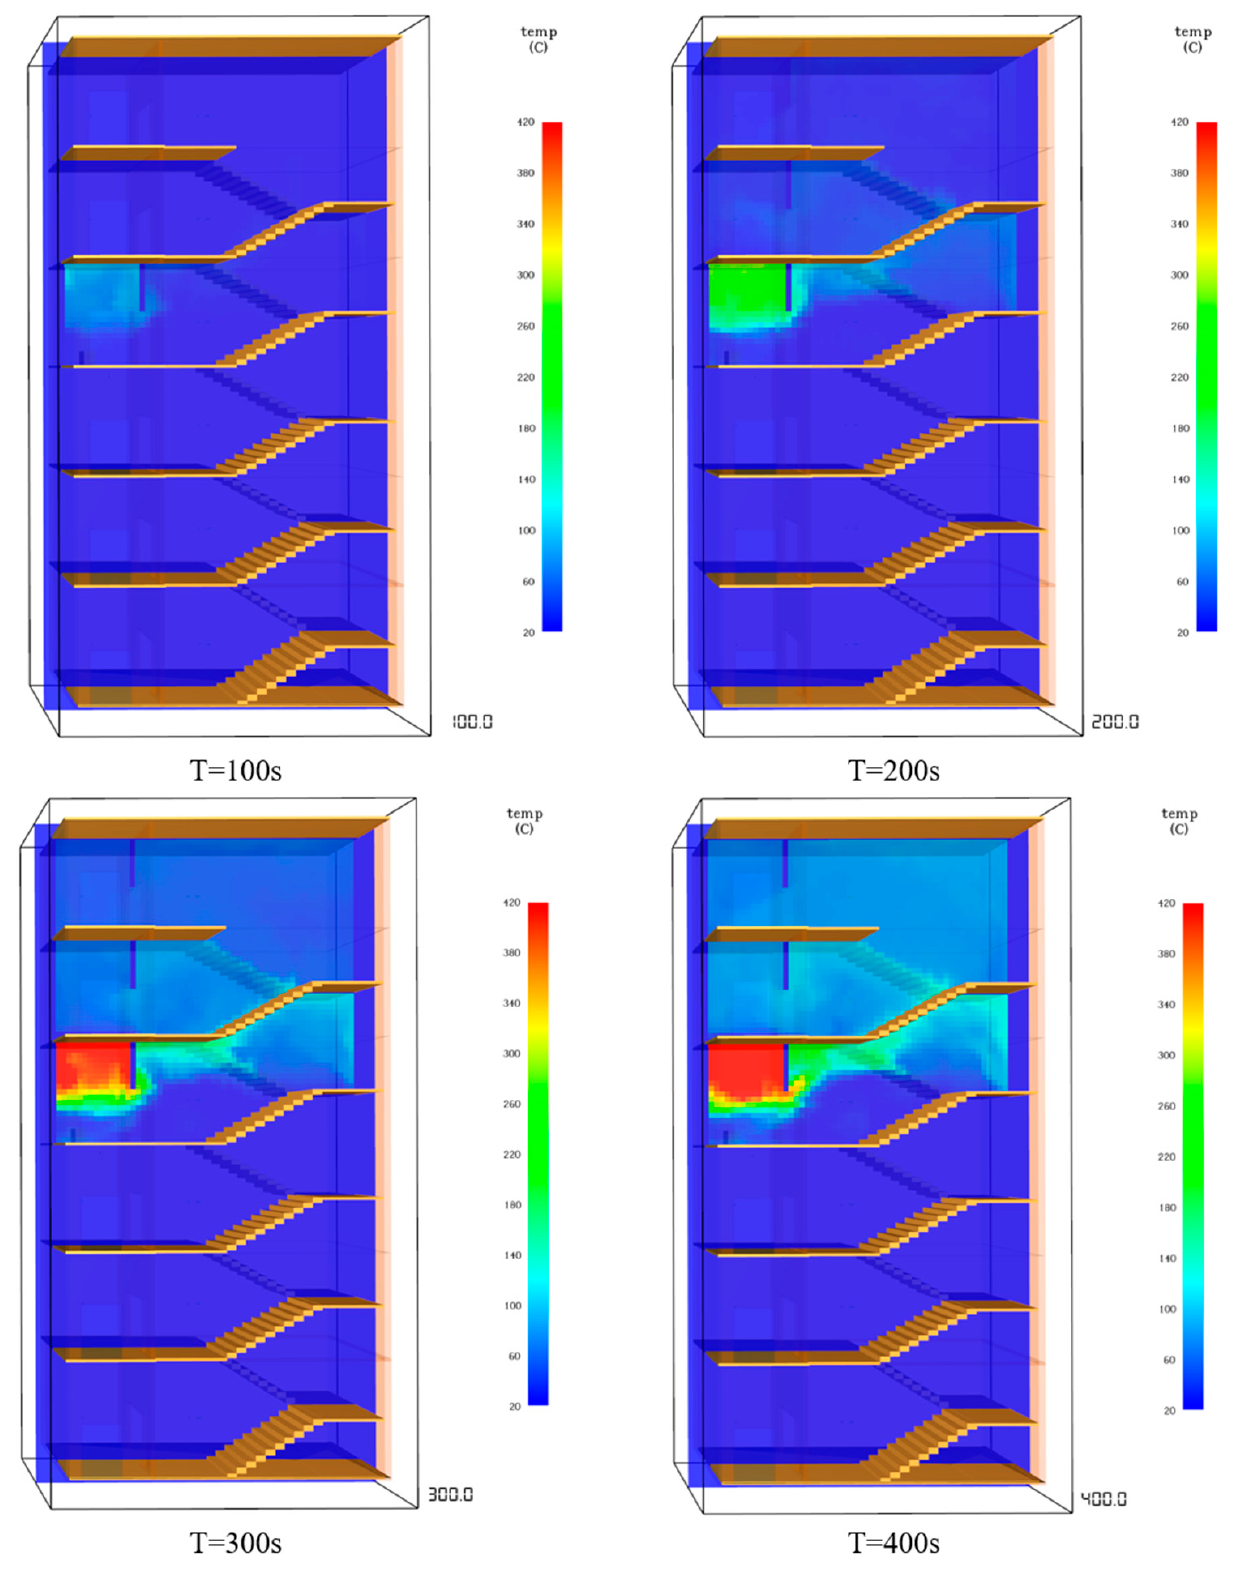
Figure 8. Temperature changes in staircase.